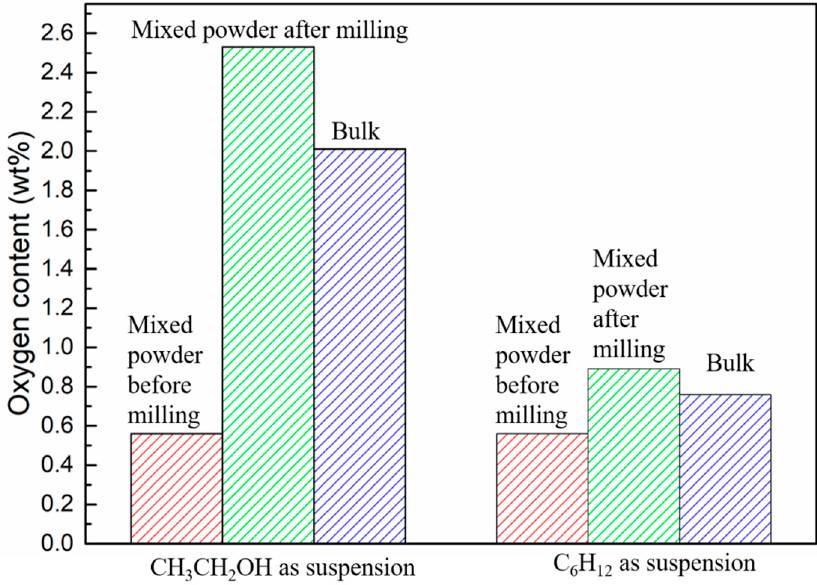
Figure4. OxygencontentofWC-Ni 3 Figure 4. Oxygen content of WC-Ni 3 Al powders before and after milling and in sintered bulk composites.